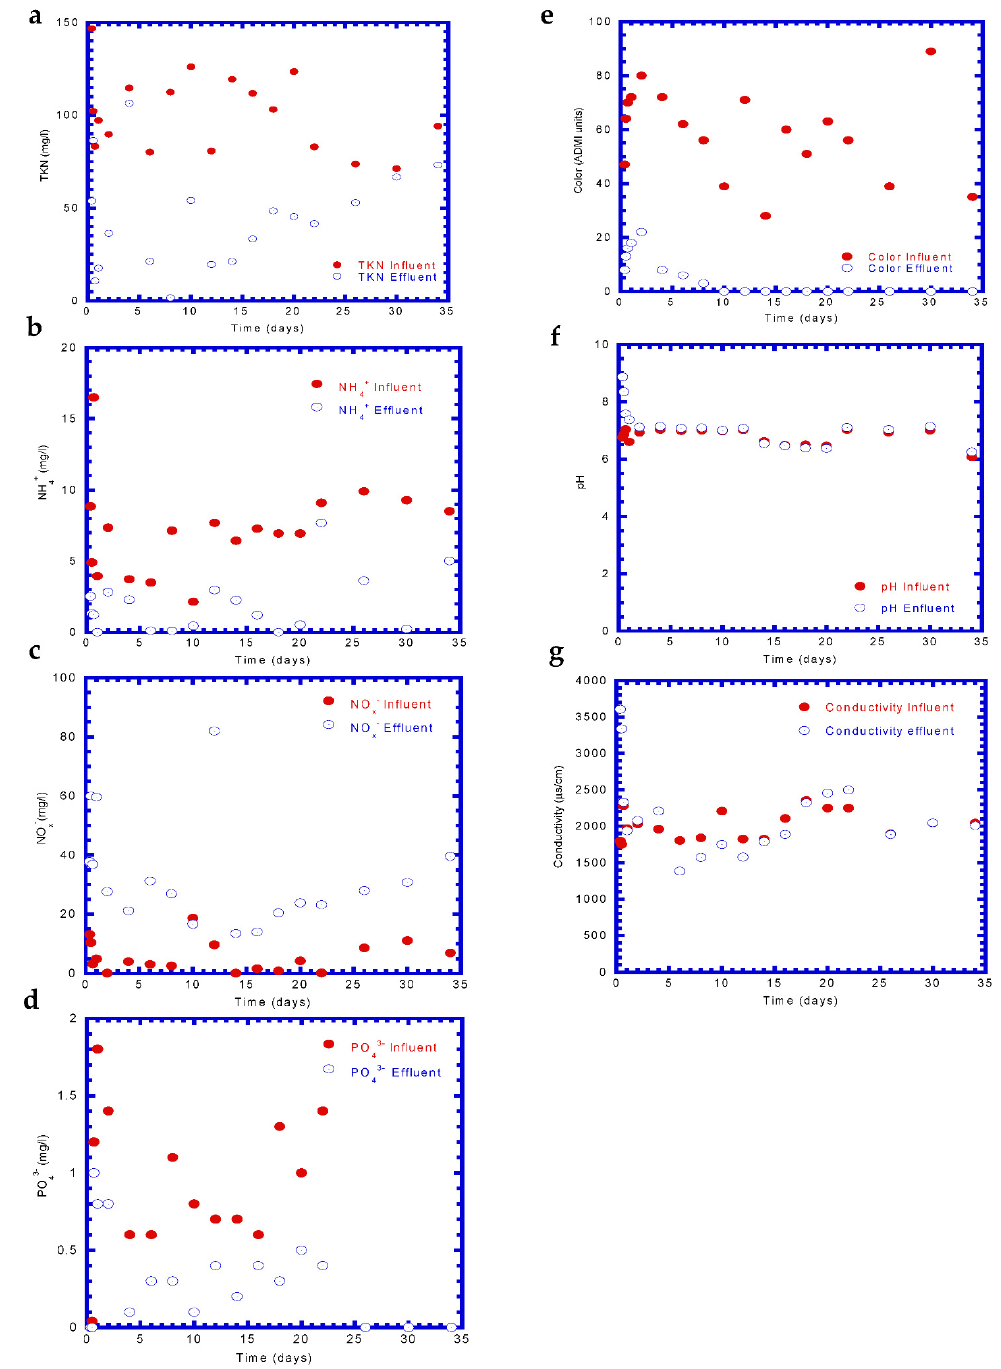
Figure 8. Time course of various analyzed substances in the influent and effluent of the BAC reactor: ( a ) TKN, ( b ) NH 4+ , ( c ) NO x – , ( d ) PO 43 – , ( e ) color, ( f ) pH, and ( g ) conductivity.